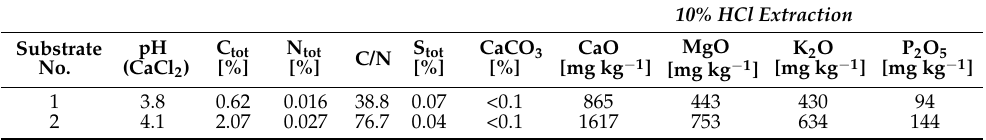
10% HCl Extraction